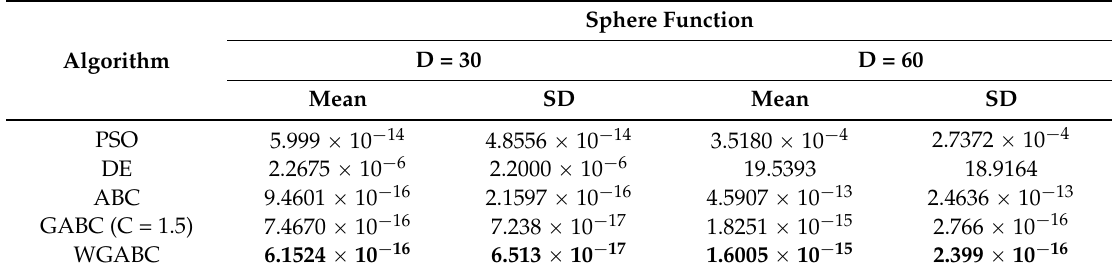
Table 2. The mean and standard deviation of the Sphere function on the different algorithms.